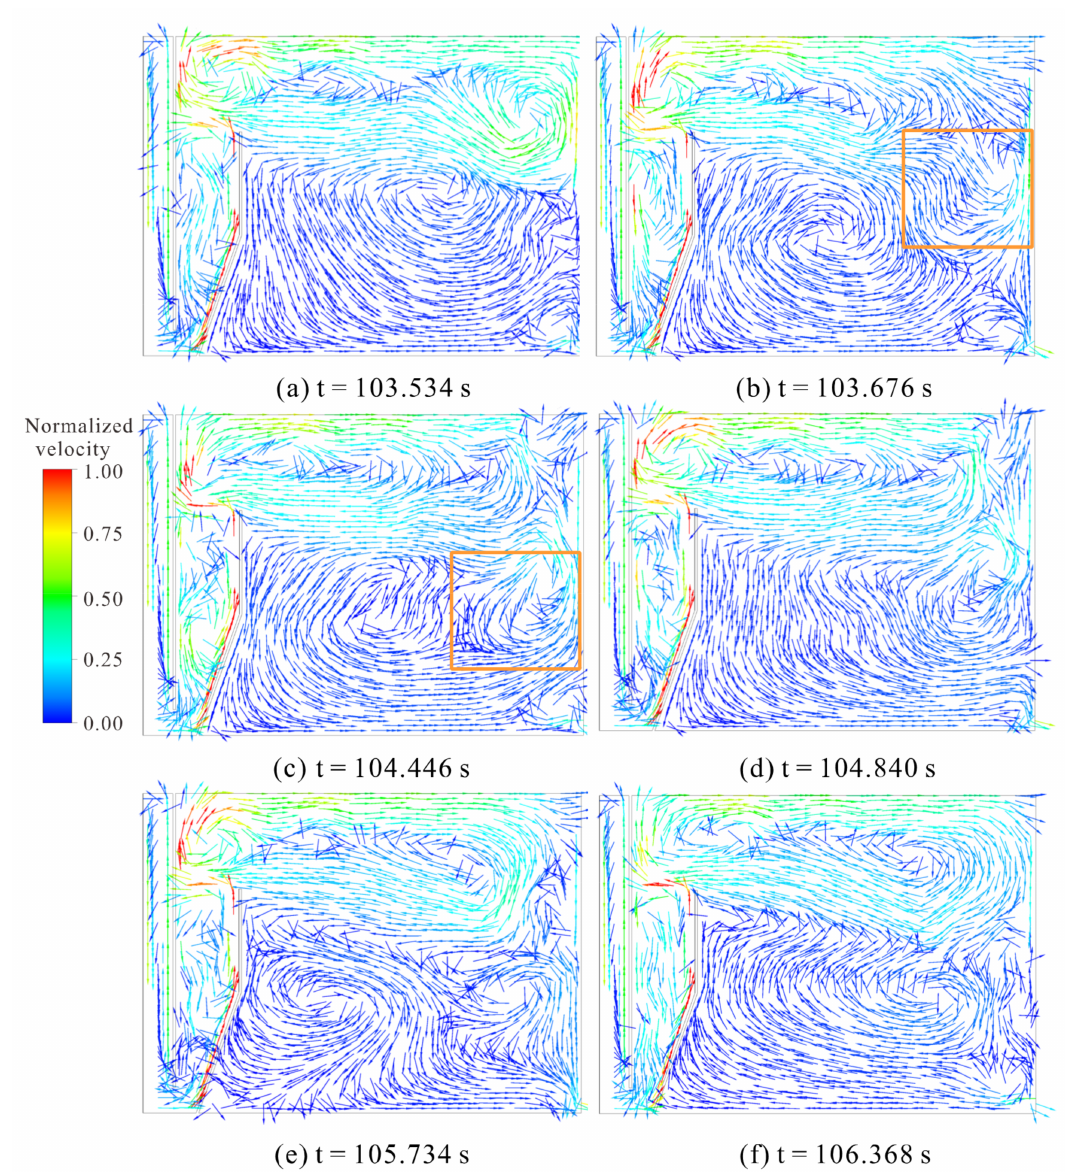
left but moved downward (shown in Figure 5a), the horizontal flow moving to the left was not enough to turn it counterclockwise. Under the influence of the vertical downward flow on the right side, the clockwise vortex became larger, and the counterclockwise vortex gradually disappeared.